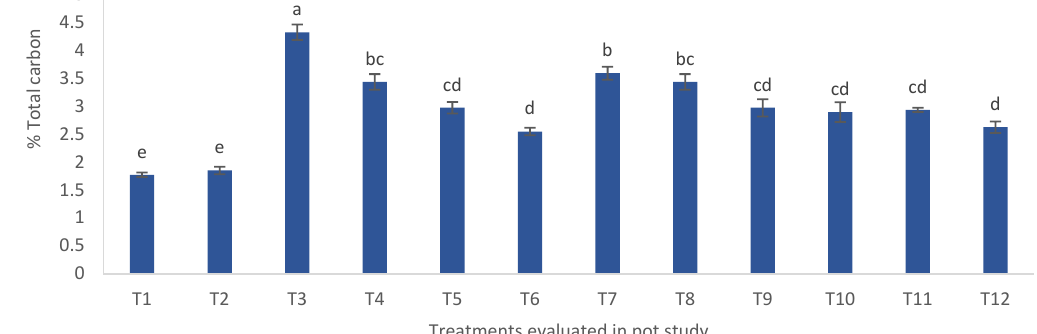
Figure 6. E ff ects of treatments on soil total organic carbon. Di ff erent letters indicate significant Figure 6. Effects of treatments on soil total organic carbon. Different letters indicate significant di ff erence between means using Tukey’s HSD (Honestly Significant Di ff erence) test at p ≤ 0.05. The difference between means using Tukey’s HSD (Honestly Significant Difference) test at p ≤ 0.05. The error bars are the ± standard error of triplicates. error bars are the ± standard error of triplicates.